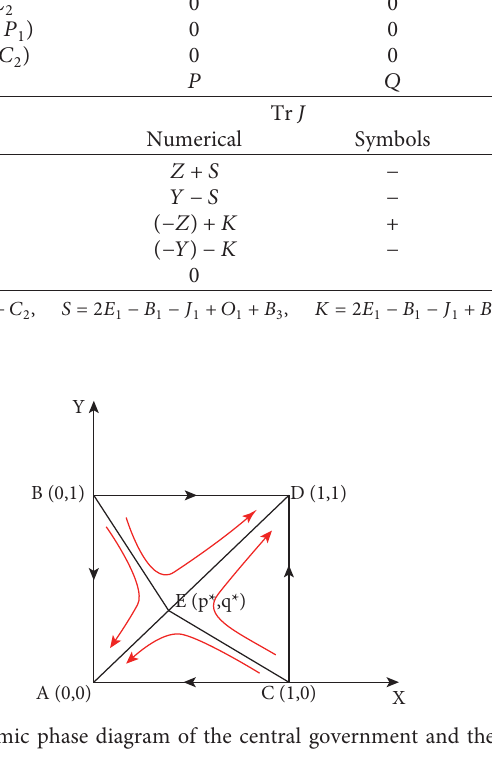
Table 3: Analysis of the stability of the equilibrium point between the central government and the local government. Equilibrium point a A ( 0 , 0 )